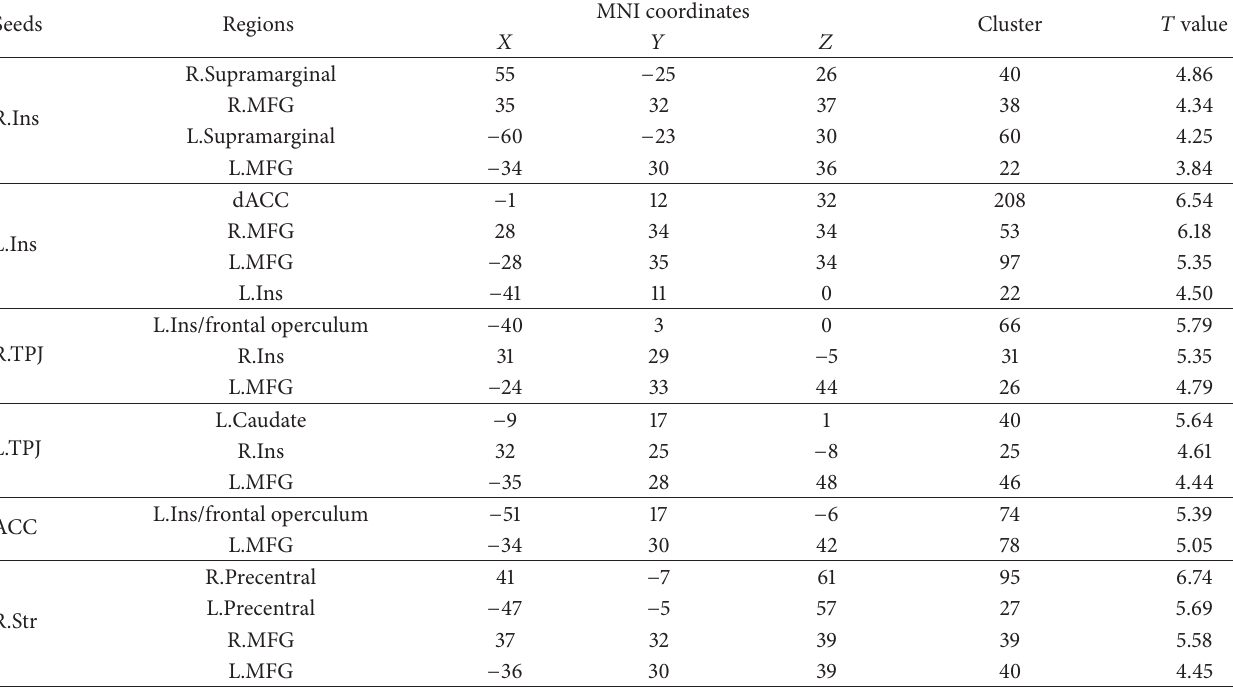
Table 3: The significantly increased functional connectivity between musicians and nonmusicians in 6 seed-maps. Seeds Regions